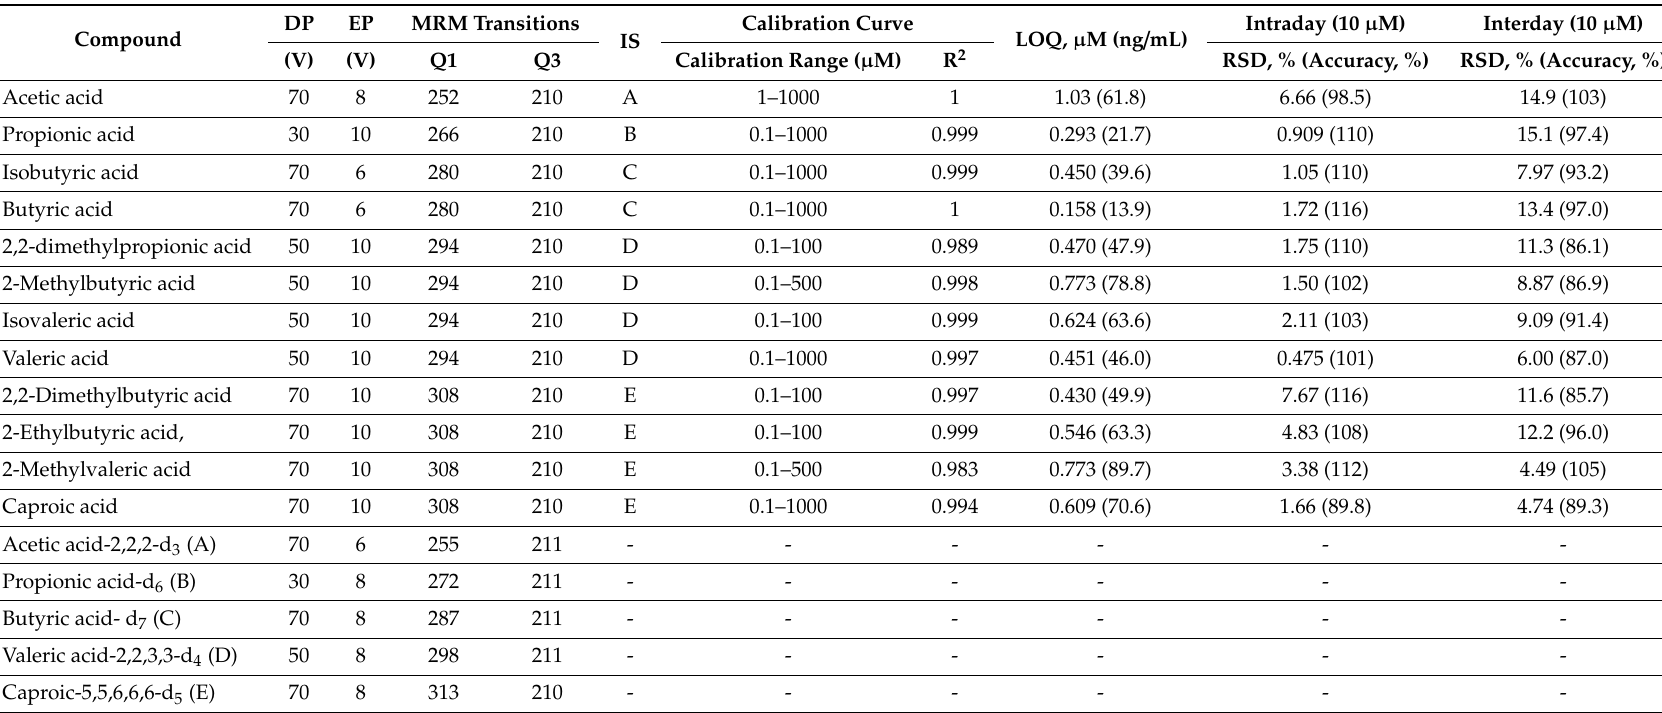
Table 1. Instrumental parameters, MS / MS transitions used in multiple reaction monitoring (MRM) mode, and analytical parameters, including LOQ (limit of quantitation), accuracy, and reproducibility were shown ( n = 3). CE (collision energy) and CXP (collsion cell exit potential) for all short chain fatty acids (SCFAs) and internal standards were 15 V and 20 V, respectively, except CXP (10 V) for acetic acid and propionic acid. DP represents declustering potential, and EP